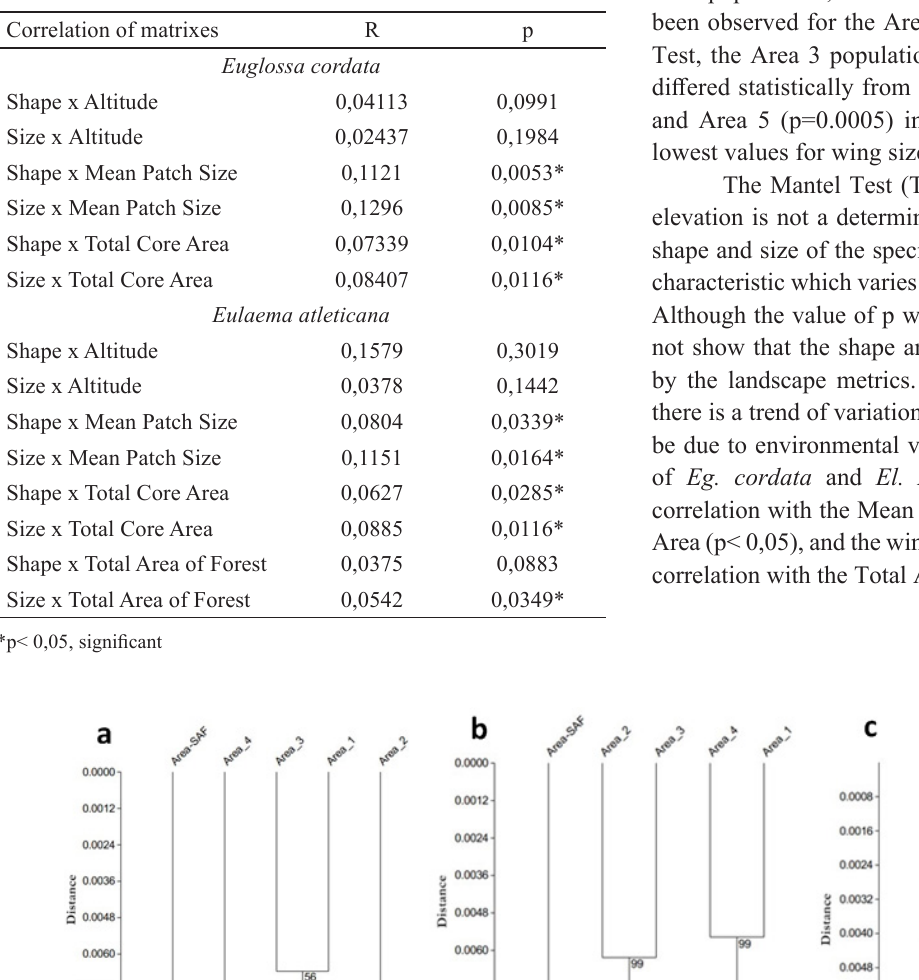
Table 4 . Mantel Test used to compare the environmental data matrices and morphometric data (wing shape and size) of Euglossa cordata and Eulaema atleticana , with 5000 permutations.